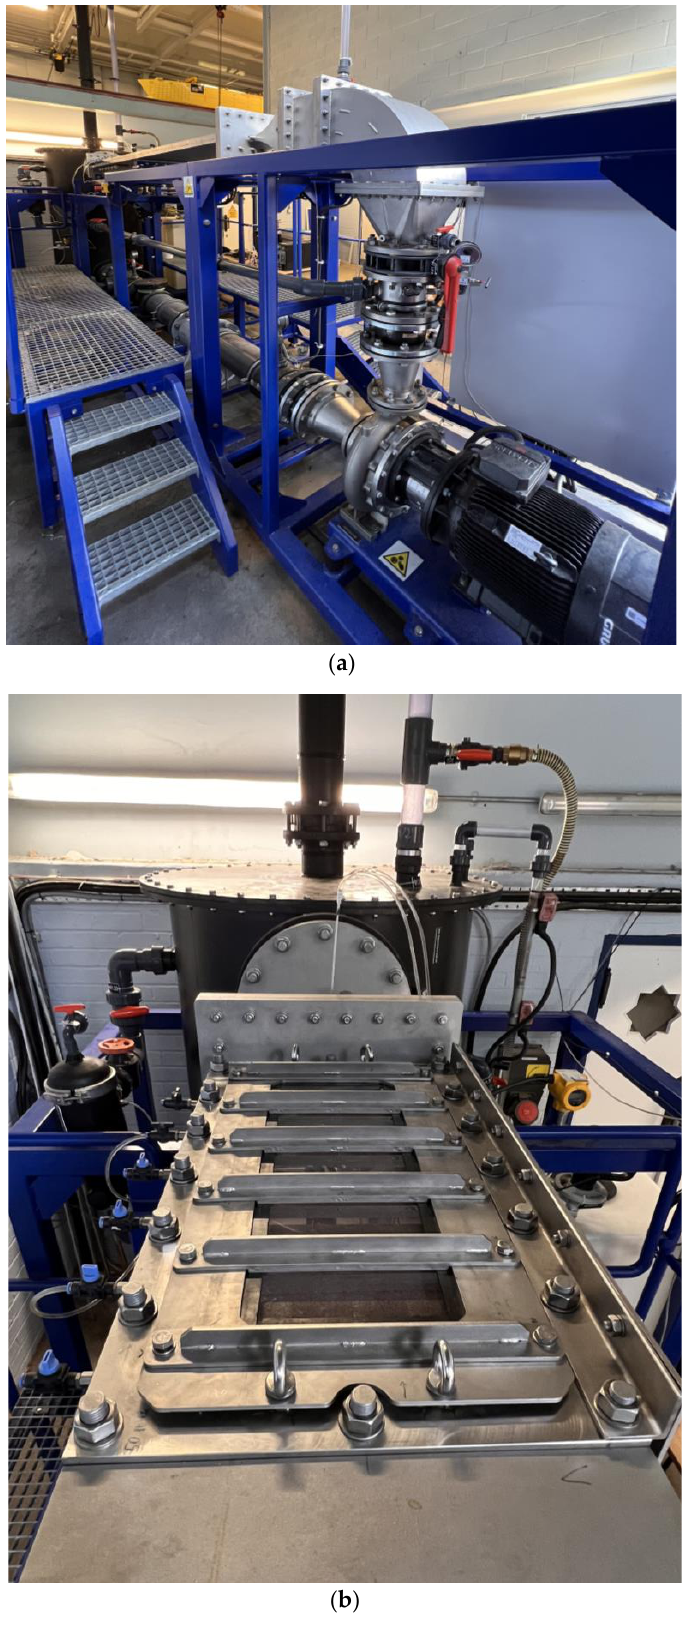
Figure 2. The Fully Turbulent Flow Channel (FTFC) of the University of Strathclyde (UoS). ( a ) On-site picture of the FTFC. ( b ) Top view of the test section accommodating a couple of transparent panels. Table 1. Main particulars of the FTFC upper limb.